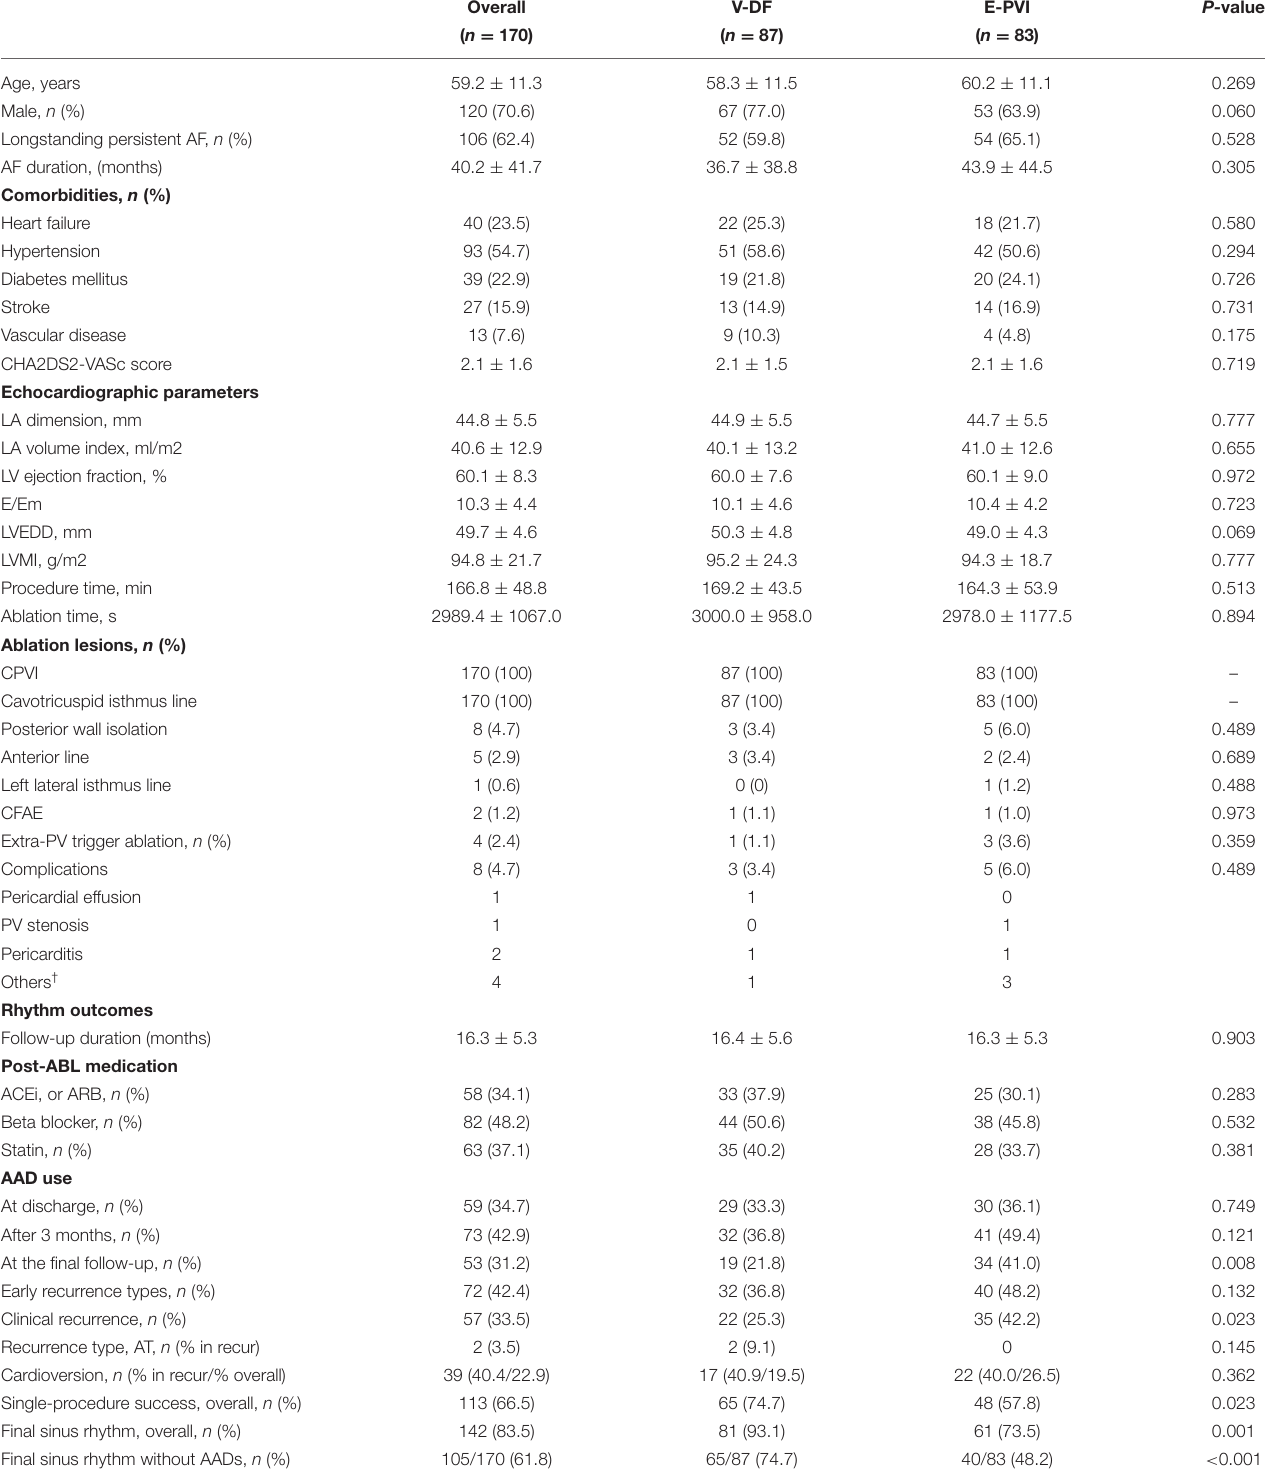
TABLE 1 | Baseline and procedure-related characteristics and rhythm outcomes of the study participants. Overall V-DF